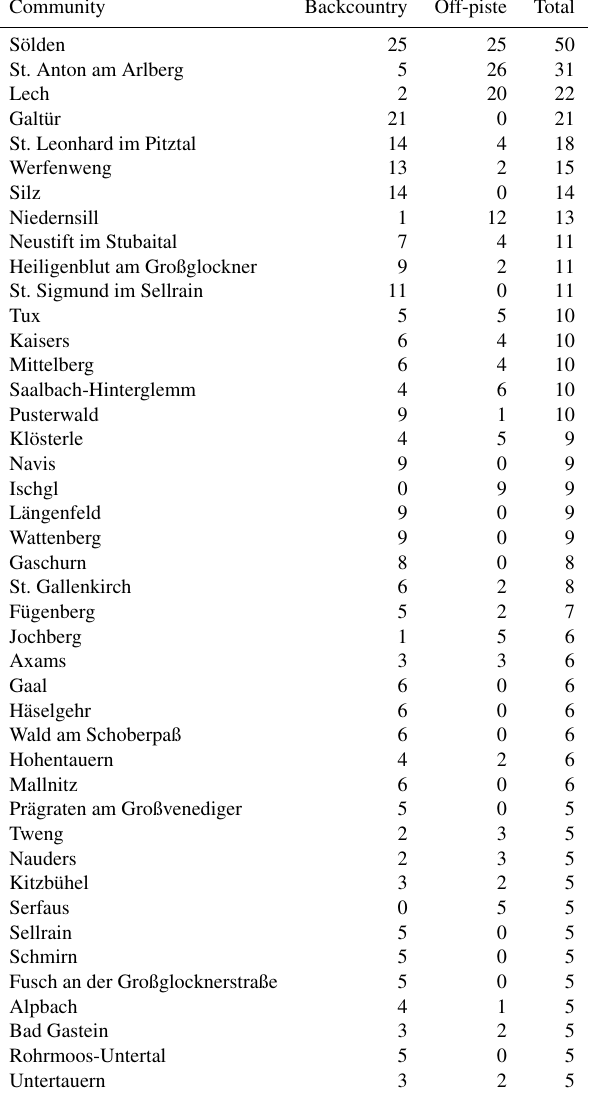
Table 3. Number of avalanche fatalities (off-piste, backcountry and total) in Austria within 1980/1981–2015/2016 stratified for commu- nities with more than four fatalities in the observation